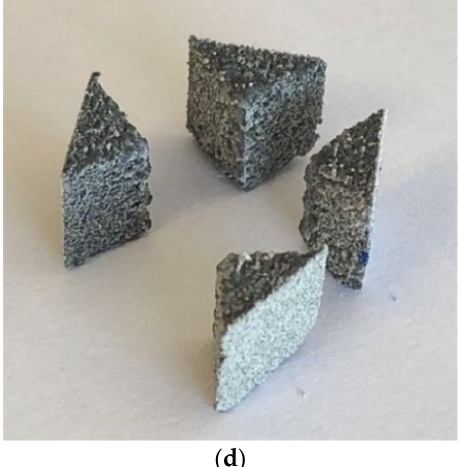
Figure 21 . ( a ) SEM images for linear 0° strategy; ( b ) SEM images for the island strategy; ( c ) SEM images for the concentric strategy; ( d ) separation of alumina sample printed using the concentric strategy.